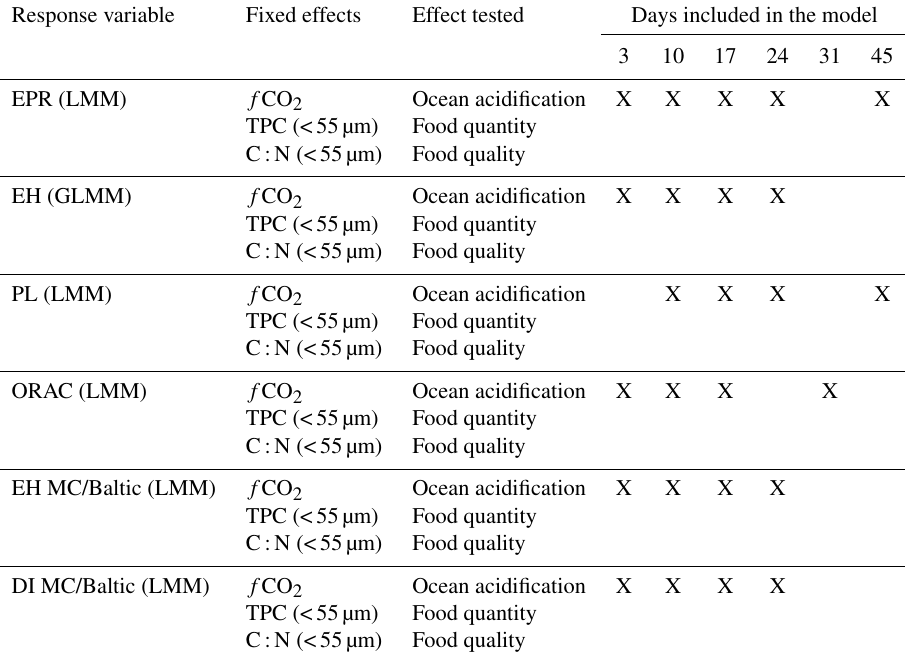
Table 1. The structure of the full LMM or GLMM models that were used to test the effects of ocean acidification, food quantity and food quality on copepod EPR, EH, PL, ORAC, the ratio of EH mesocosm / EH Baltic and the ratio of nauplii DI mesocosm / DI Baltic. The sampling days that were included in each of the models are listed. Repeated measures of the same mesocosm bags were used as a random effect in all the models, because copepods that come from the same bags are more alike than copepods from different bags.